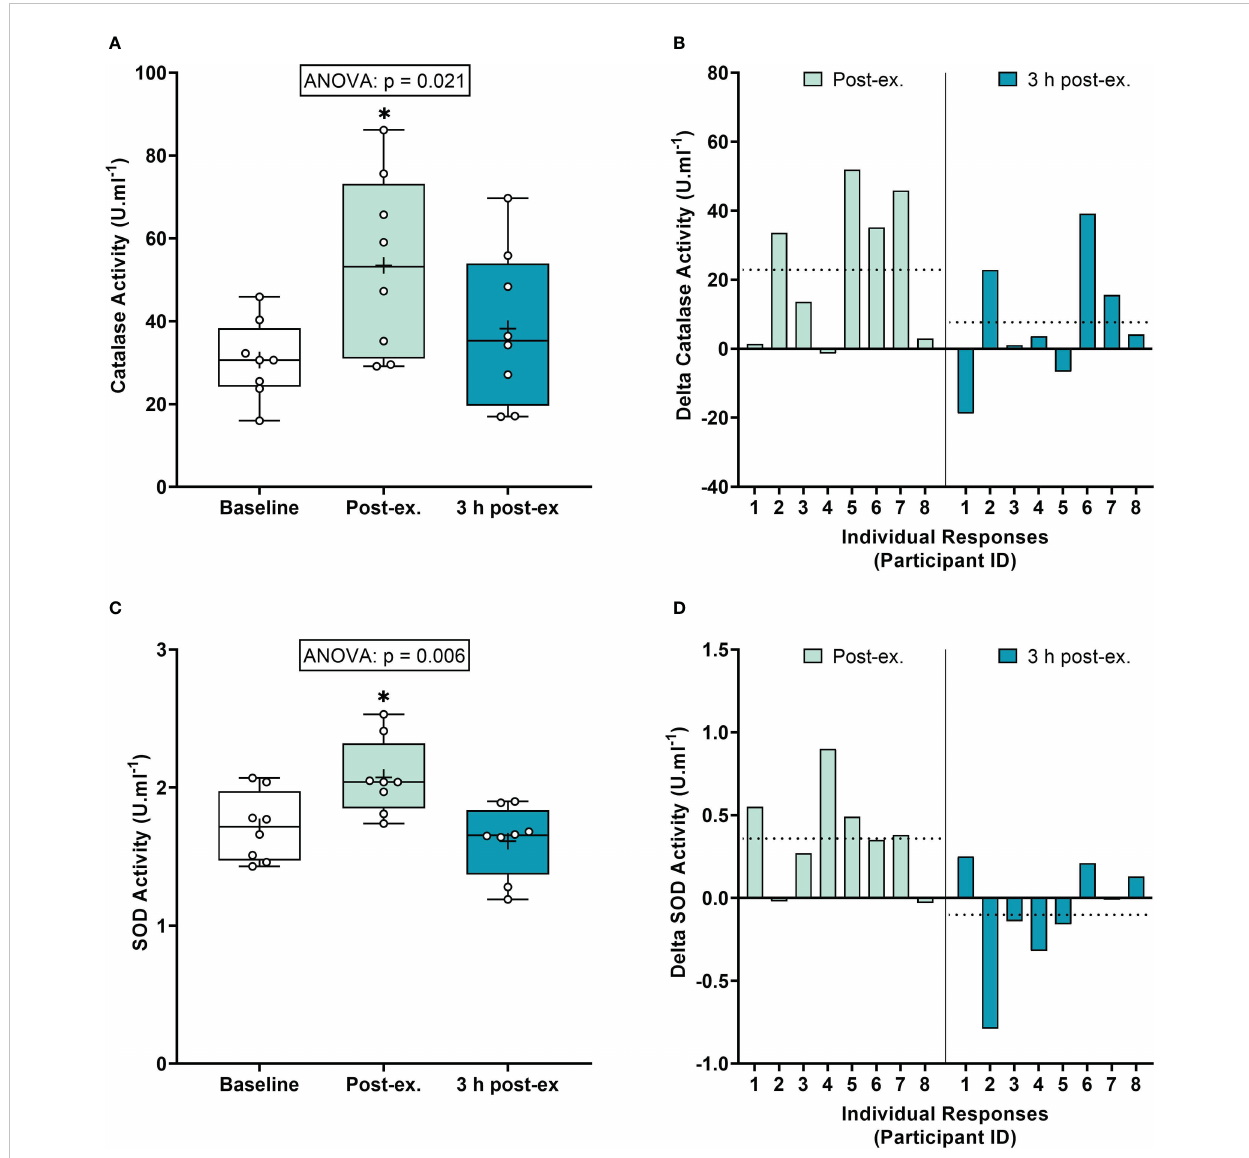
FIGURE 2 Serum catalase activity (A, B) and plasma superoxide (SOD) activity (C, D) at baseline, immediately after exercise, and 3 h post-exercise. Group averages and individual data (A, C) are presented as Box and Whisker plots. The Box represents the interquartile range alongside the median